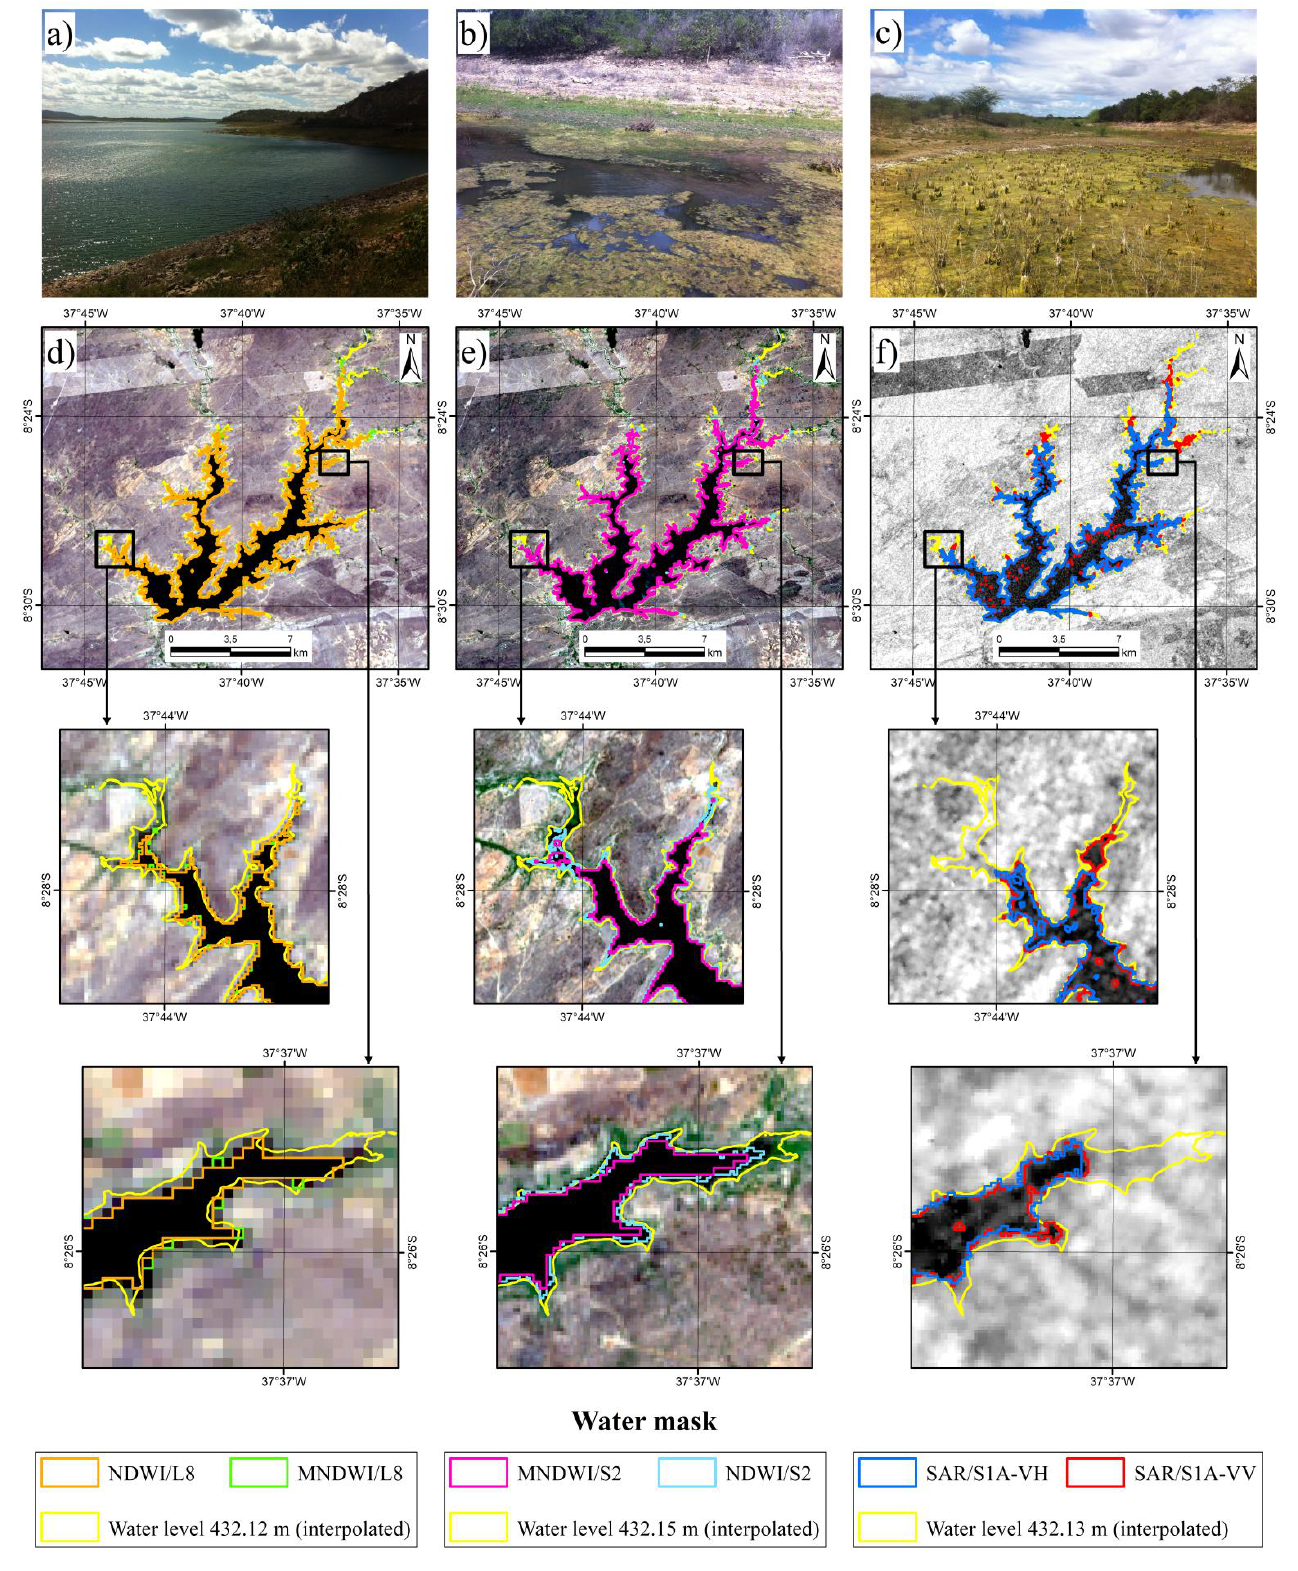
Figure 17. Water delimitation with a high water level: ( a ) reservoir, ( b ) eutrophication, and ( c ) typical eutrophicated inlet branch, ( d ) Landsat-8 (24 September 2020), ( e ) Sentinel-2 (17 September 2020), and ( f ) Sentinel-1A (21 September 2020).